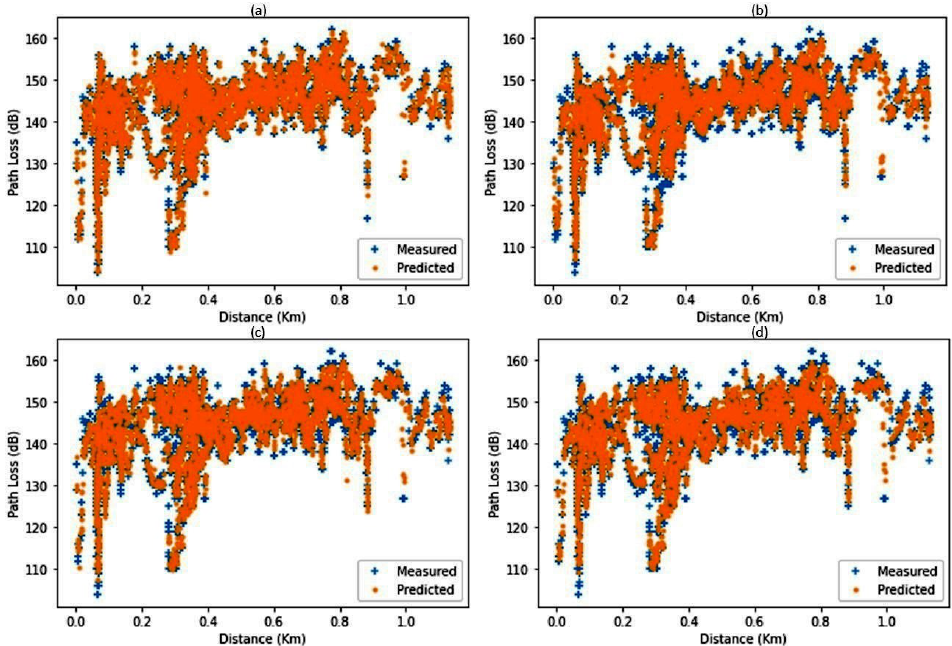
Figure 17. Predictions in suburban environment based on ( a ) DRS on dataset 1, ( b ) DES on dataset 1, ( c ) DRS on dataset 2, ( d ) DES on dataset